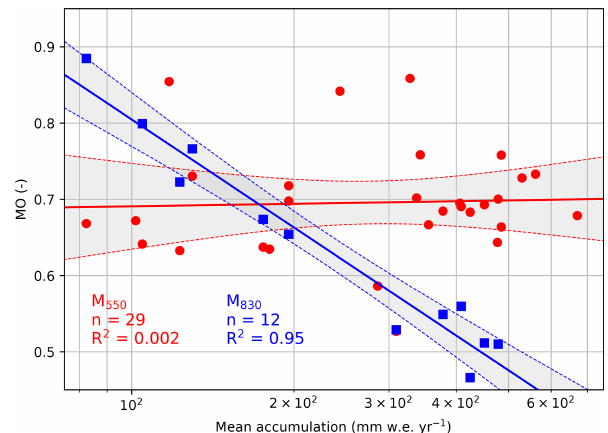
Figure 2. Ratio between modelled and observed depth at which the density reaches 550kgm − 3 (MO 550 ) or 830kgm − 3 (MO 830 ) as a function of local accumulation rate. The solid lines represent the corresponding regressions, and the grey bands around them are their corresponding 95% confidence